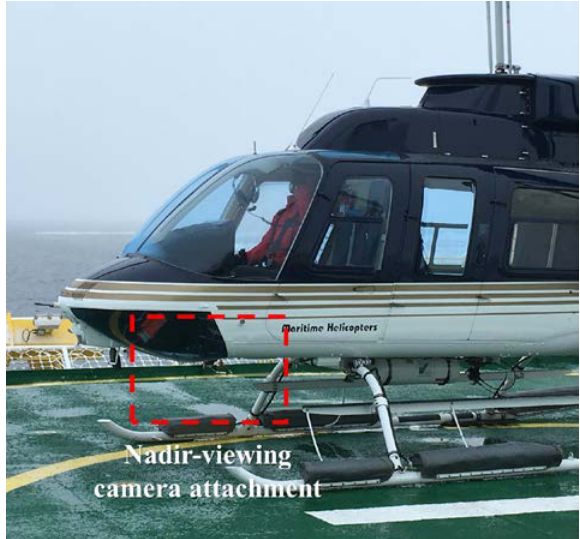
Figure 2. Details for installation of imaging equipment on